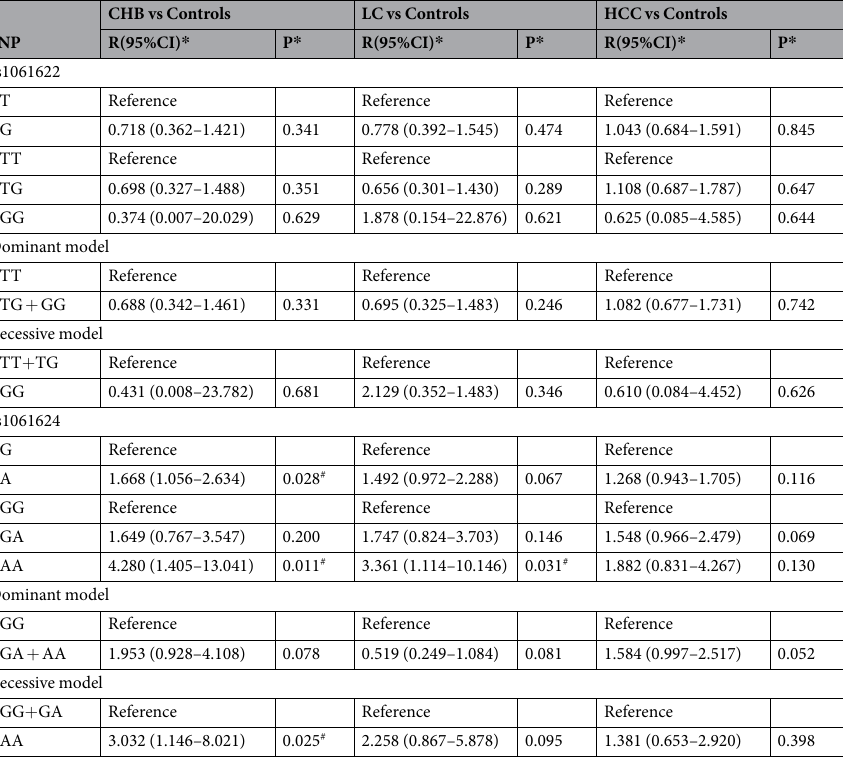
Table 3. Risk estimation between TNFR2 genotypes and HBV-related diseases in males. * Adjusted for age, gender,ethnicity, smoking and alcohol consumption, and BMI. # The data reaches a statistical significant